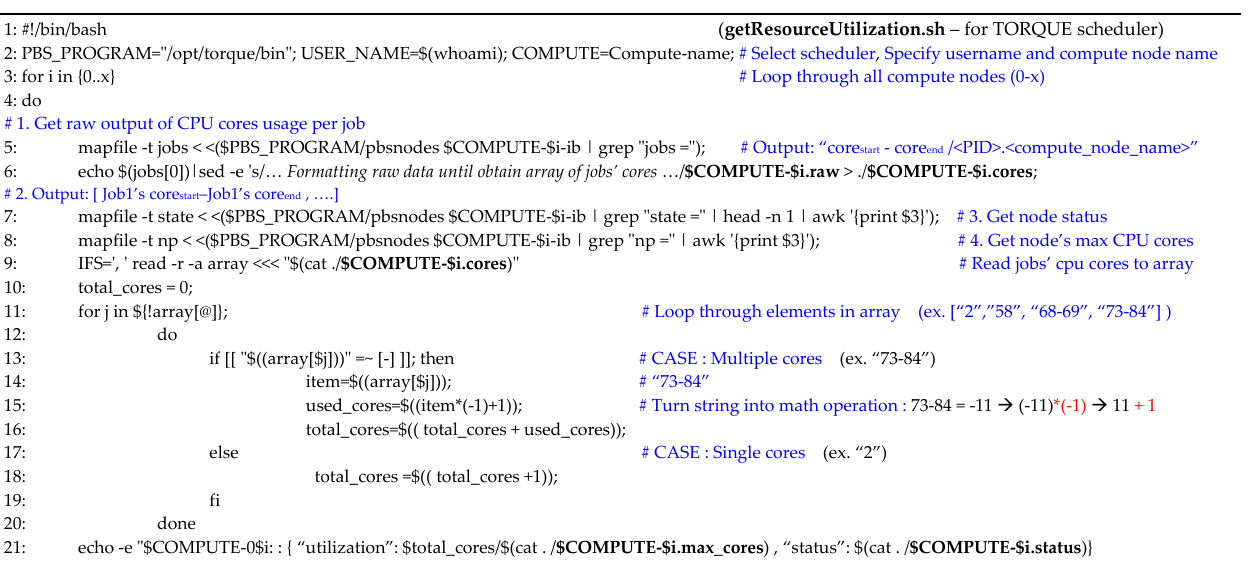
Table 2. Average Latency in Transaction Processing (Total transactions submitted = 300, Rate = 100 TPS *).